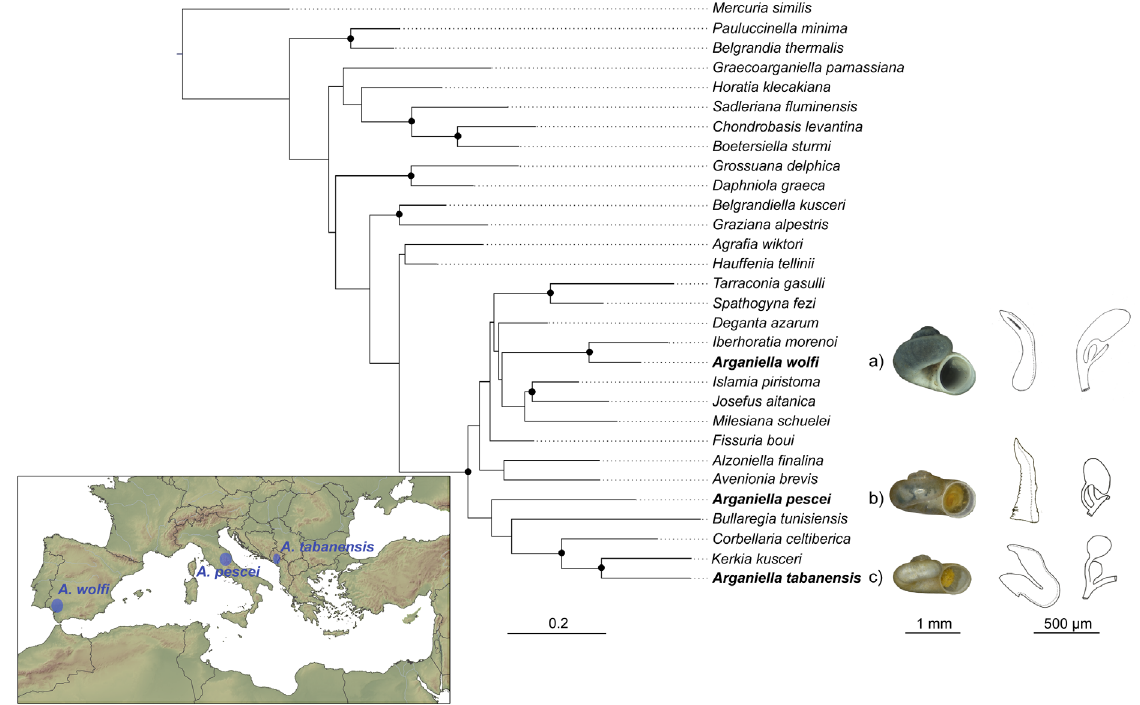
Fig. 1. Maximum likelihood tree based on the combined (COI, 18S) dataset. Statistical support of the nodes is indicated when Bayesian posterior probabilities ≥ 0.95 and bootstrap supports ≥ 75% (black dots). On the right, the morphology of shell, penis and distal female genitalia is presented for: a) Arganiella wolfi Boeters & Glöer, b) A. pescei Giusti & Pezzoli, 1980 and c) A. tabanensis Boeters, Glöer & Pešić, 2014. Reproductive organs were re-drawn from Arconada & Ramos (2007a), Bodon et al. (2001) and Boeters et al. (2014) for the three species, respectively. Scale bar below topology: substitutions per